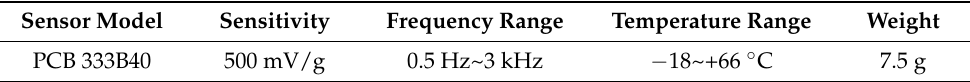
Table 6. Sensor parameters.